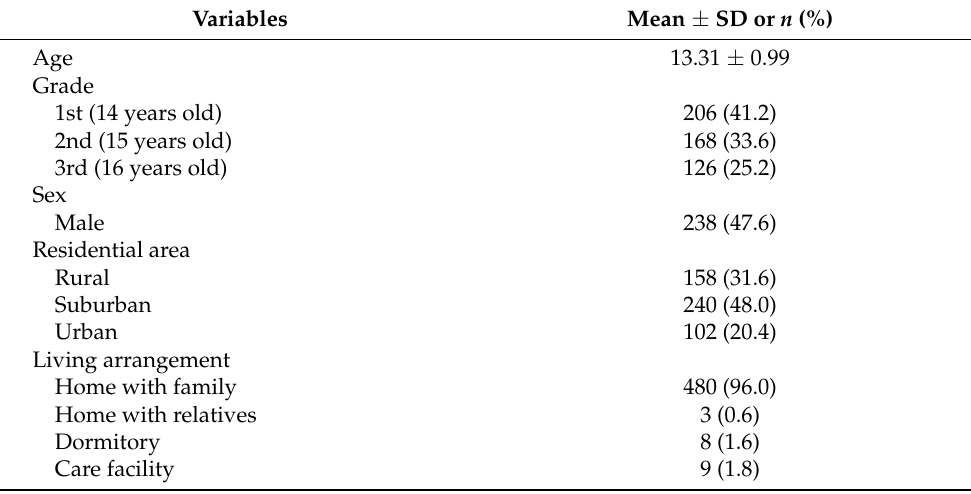
Table 1. Sociodemographic characteristics of the participants ( N =